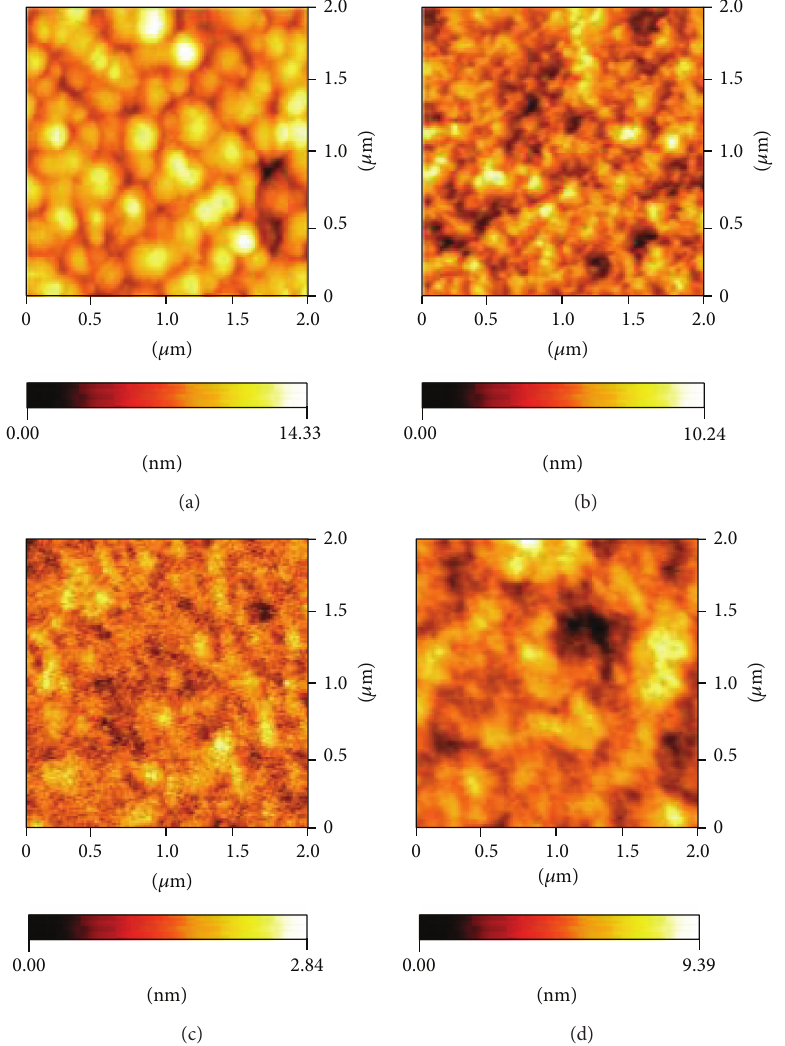
Figure 7: AFM images of the PTB7/PC 71 BM thin films: (a) prepared with pristine CB, (b) prepared with CB and DIO (3v%), (c) prepared with CB and CN (3 v%), and (d) prepared with CB and DIO (3v%)+CN (3 v%).